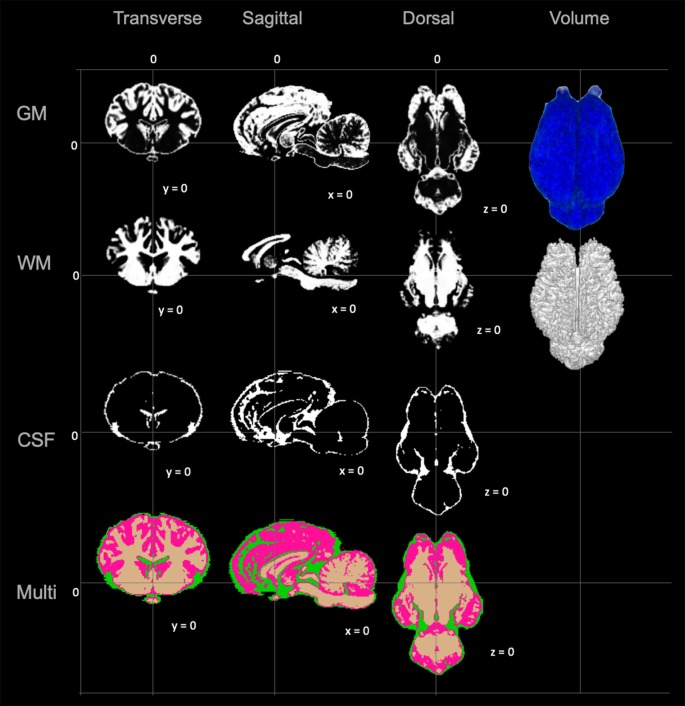
Visual demonstration of the TSMs. The gray matter (GM) map, white matter (WM) map, cerebrospinal fluid (CSF) map and a combination of all maps (Multi) are demonstrated in mid transverse, mid sagittal and mid dorsal planes. Volume rendered images for the GM and WM maps are also included in the right column.